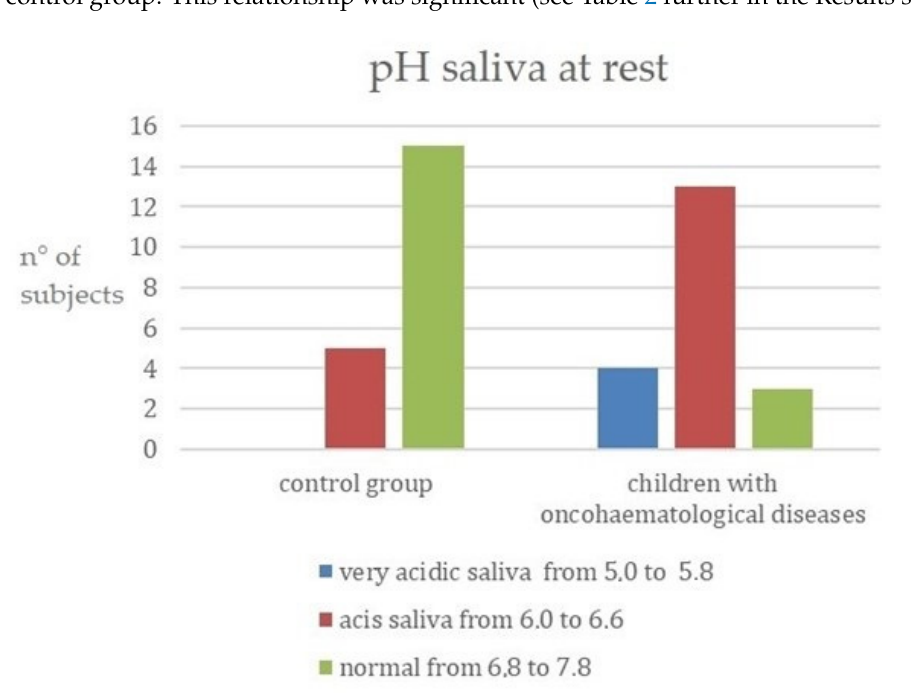
Figure 2. Viscosity of saliva at rest. (Y axis: n° of subjects = number of subjects for each category). Table 2. Fisher’s exact test for the salivary test executed on controls and oncohematological group [11,12].